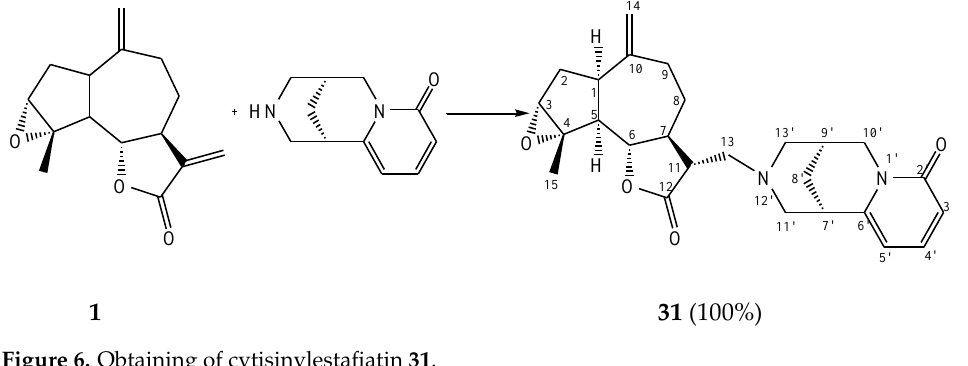
Figure 6. Obtaining of cytisinylestafiatin 31.